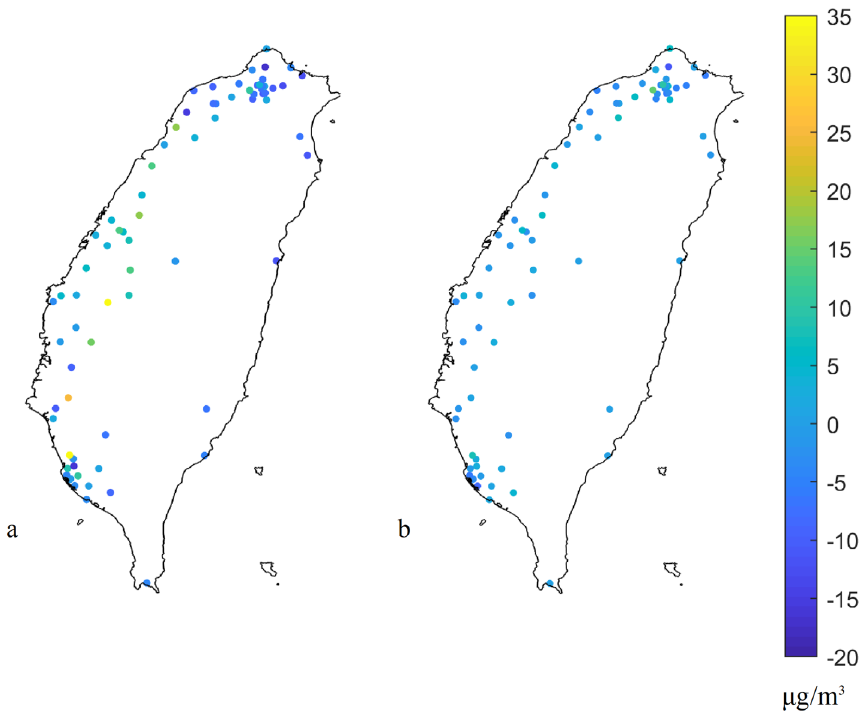
Figure 7. Patterns of model residuals from the ( a ) nonspatial and ( b ) spatial calibration models. The plots were created in MATLAB_R2018B (https ://www.mathw orks.com/produ cts/matla